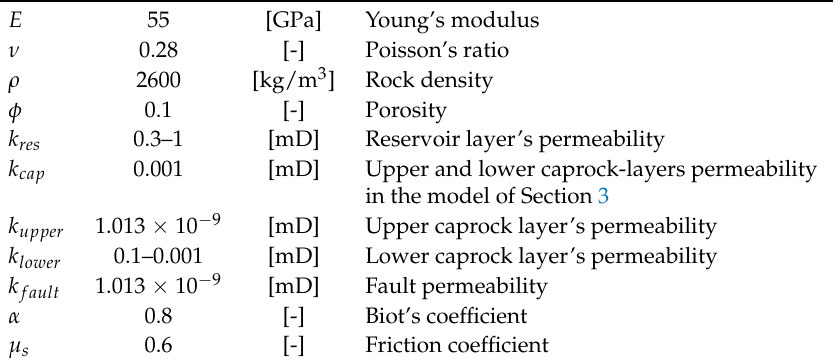
Table 1. Mirandola fault and Cavone oilfield modeling: Material